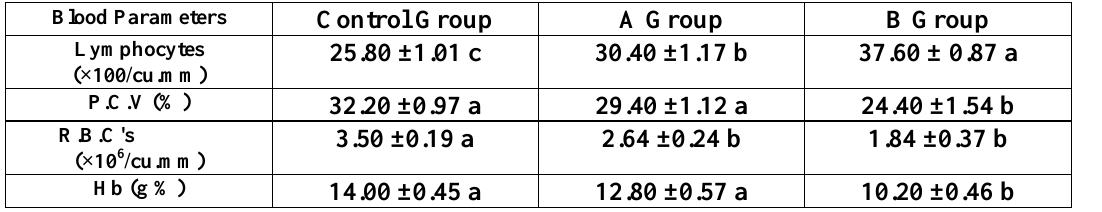
Table (2) Lymphocyte, PCV, RBC's count and Hemoglobin of Mice dosed with MSG at a dose of 3g and 6g per Kg of body weight (after being adjusted according to the body weight) for fourteen